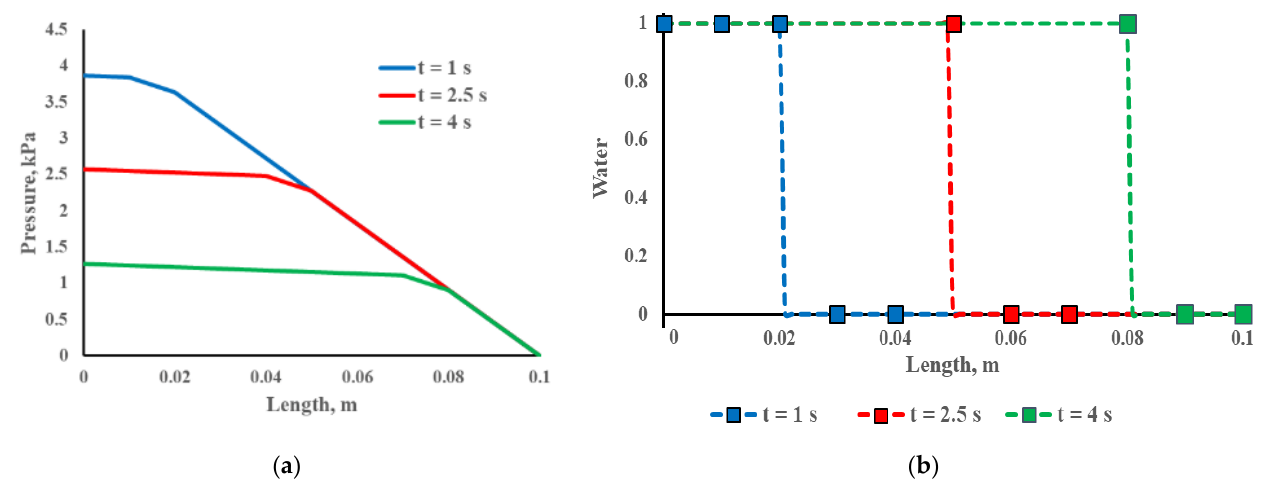
Figure 8. ( a ) Pressure distribution along the length of the microchannel and ( b ) the position of the waterfront at different times for the variant with a wetting angle of 40°. Dotted line — analytical solution, markers — calculation.